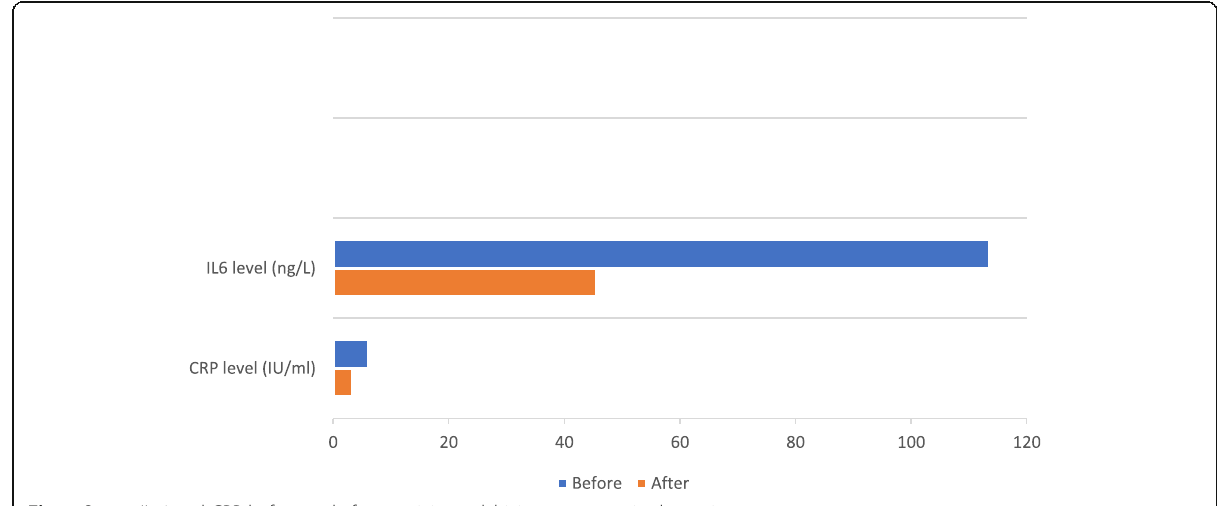
Fig. 1 Serum IL-6 and CRP before and after receiving colchicine treatment in the patient group